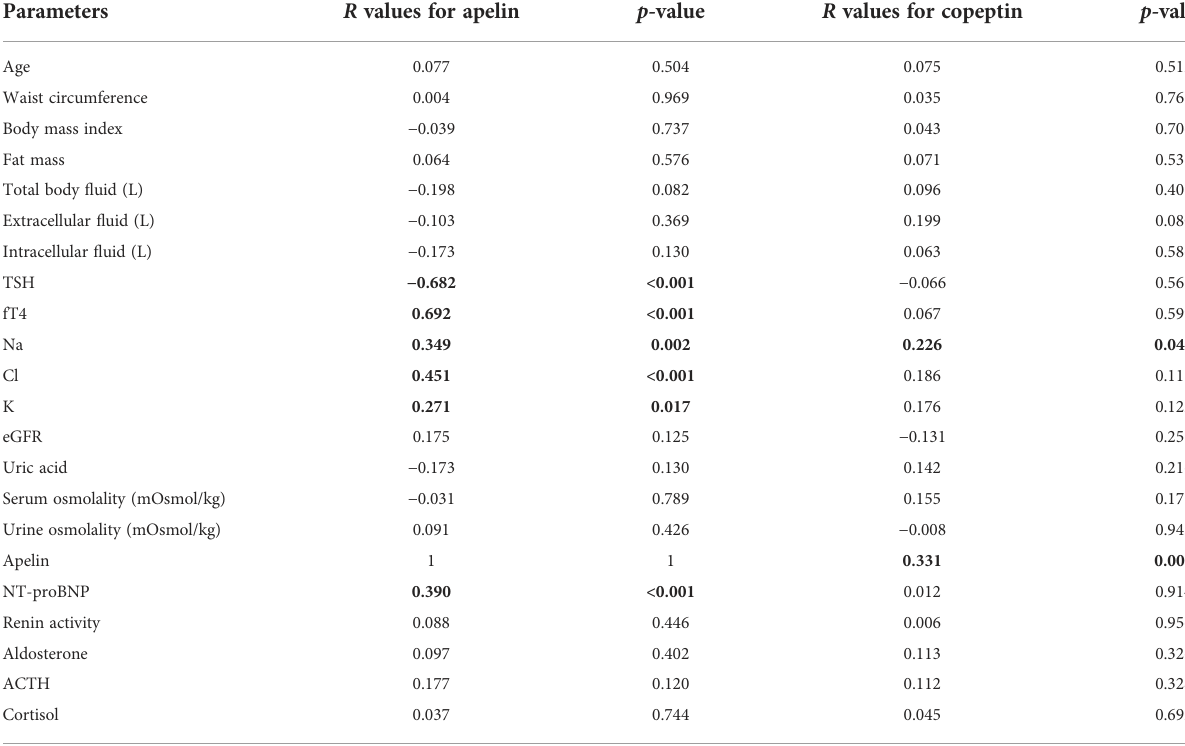
TABLE 2 Relations of apelin and copeptin to the selected anthropometric and biochemical parameters. Parameters